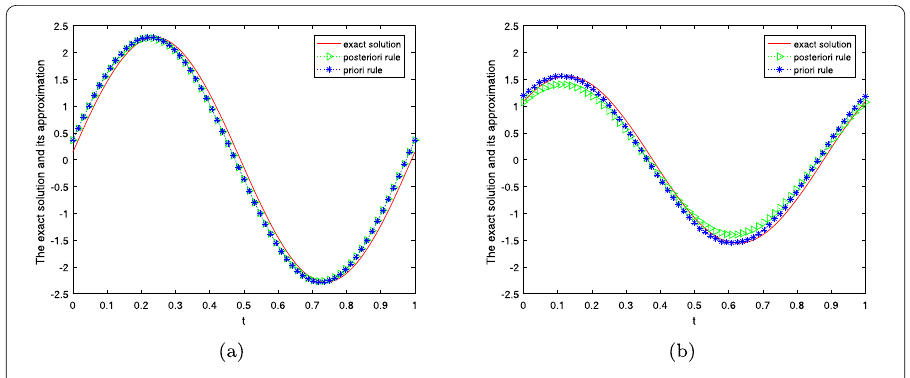
Figure 1 The comparison of the exact solution and its approximation solution for (cid:13) = 0.01 at x = 0.8 with Example 5.1, ( a ) α = 0.1, ( b ) α = 0.7